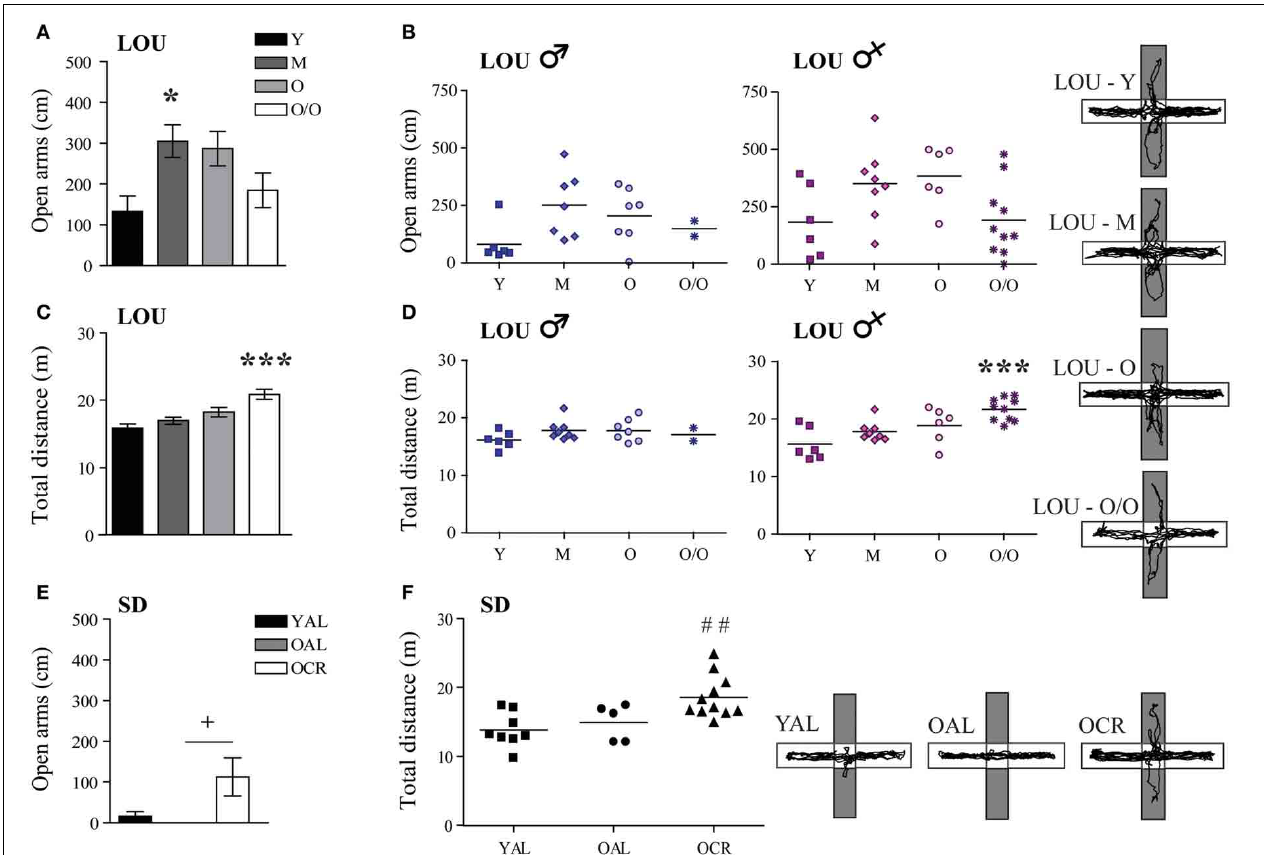
FIGURE 4 | LOU rats exhibit a low anxiety phenotype in the elevated plus maze task and LTCR reduces anxious behavior in old SD rats. (A) LOU rats traveled over 100cm on the EPM open arms, revealing high explorative behaviors and low anxiety. (B) No significant difference was observed between aging male and female LOU rats. (C) Locomotor activity increased with age for the LOU rats to become significantly different in O/O rats. (D) This effect is specific to females. (E) OAL SD rats did not explore the EPM open arms, indicating stress-related anxious behaviors. LTCR enhanced